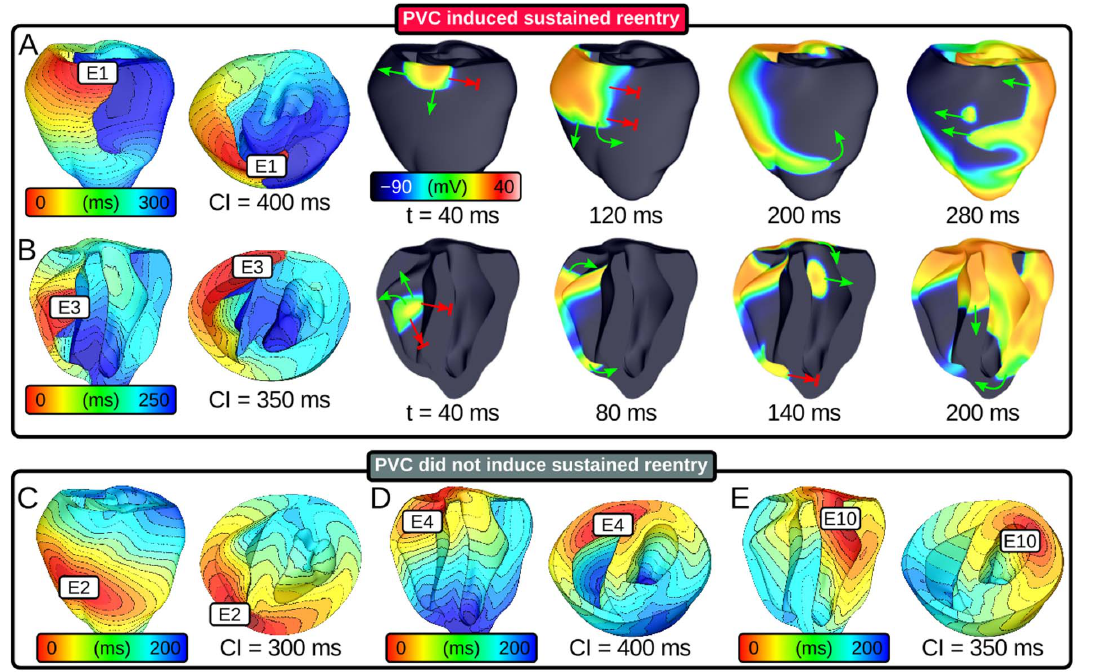
Figure 3. Response to ectopic stimulation in simulations with 30% I Na and arrested sinus. (A–B) Activation sequences and V m maps showing sustained arrhythmia induction by PVCs originating in two locations. Green arrows: successful wavefront propagation; red arrows: conduction block. (C–E) Activation sequences for three ectopic stimulation sites from which no episodes of sustained reentry were induced. Activation times measured relative to PVC delivery. Time scales vary from panel to panel but spacing between isochrones lines is always 10 ms . V m : membrane voltage; PVC: premature ventricular contraction. doi:10.1371/journal.pone.0086947.g003 PLOS ONE |